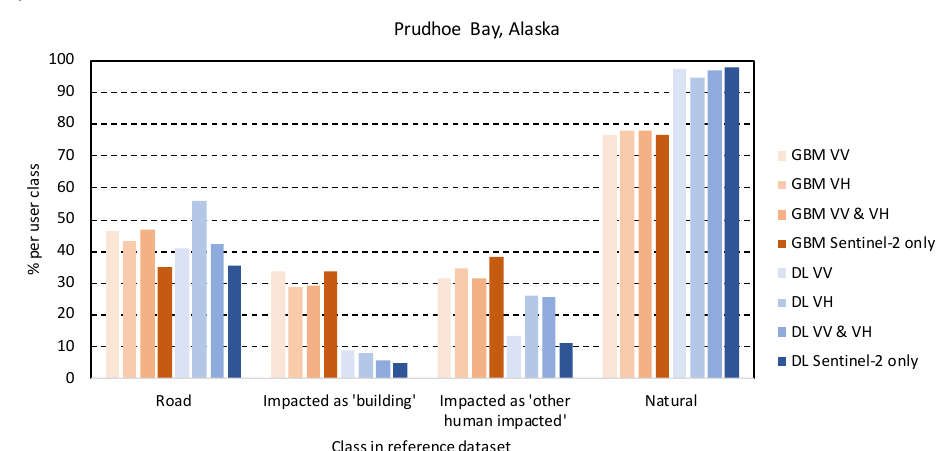
Figure 9. Classification performance results (( a ) users and ( b ) producers accuracy) for Prudhoe Bay, Alaska (validation data source [3]). DL—Deep Learning, GBM—Gradient Boosting Machines, V—vertical polarization, H—horizontal polarization.